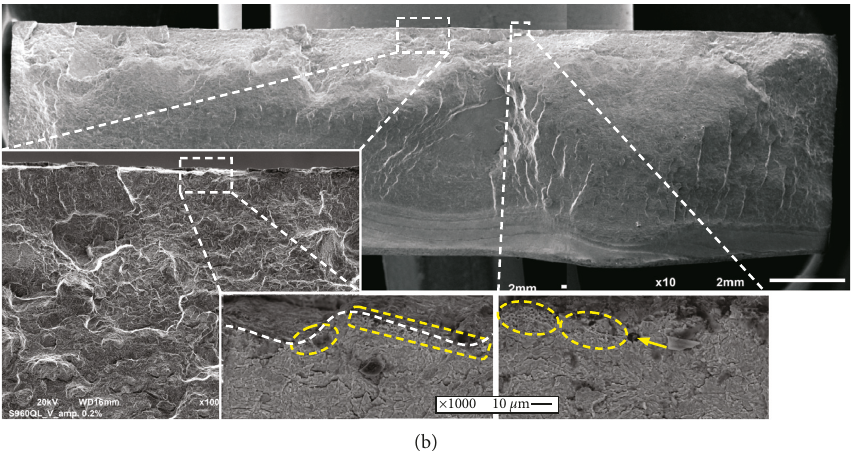
Figure 6: The pictures of fatigue fractures have been observed during fractographic investigation. Samples of weldments made of S960QL steel tested under the total strain amplitude ε a � 0.2%: (a) I-shaped and (b) V-shaped